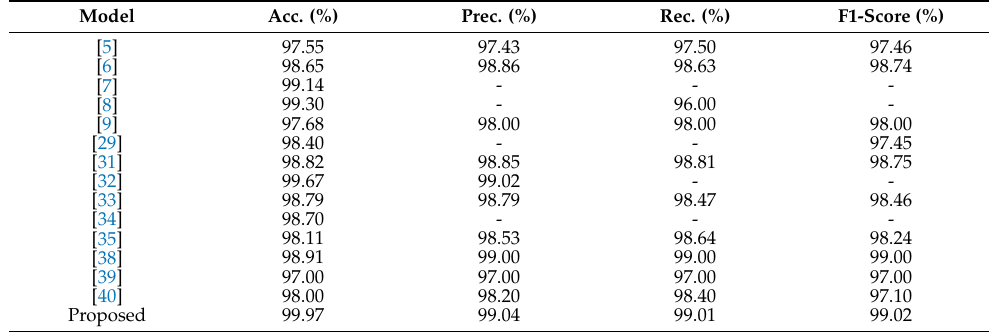
Table 9. Comparative analysis between the proposed multi-classification framework and related ML and DL-based malware multi-classification approaches tested on the Malimg